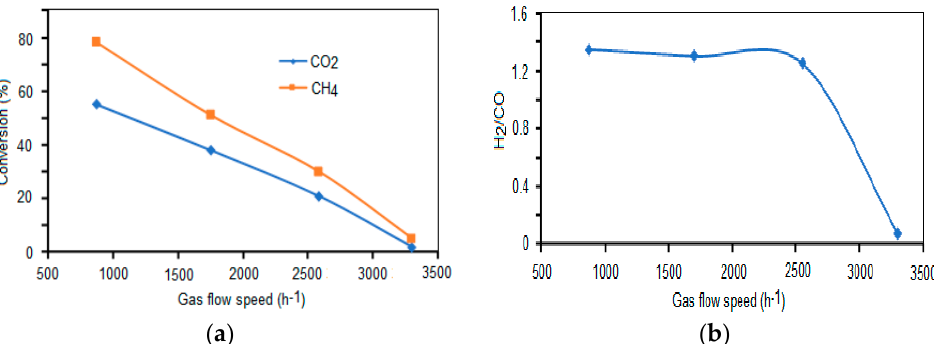
Figure 10. Influence of gas flow speed on the CH 4 and CO 2 conversion ( a ) and H 2 /CO ratio ( b ) (catalyst 3 Mn-Ni, 900 °C).